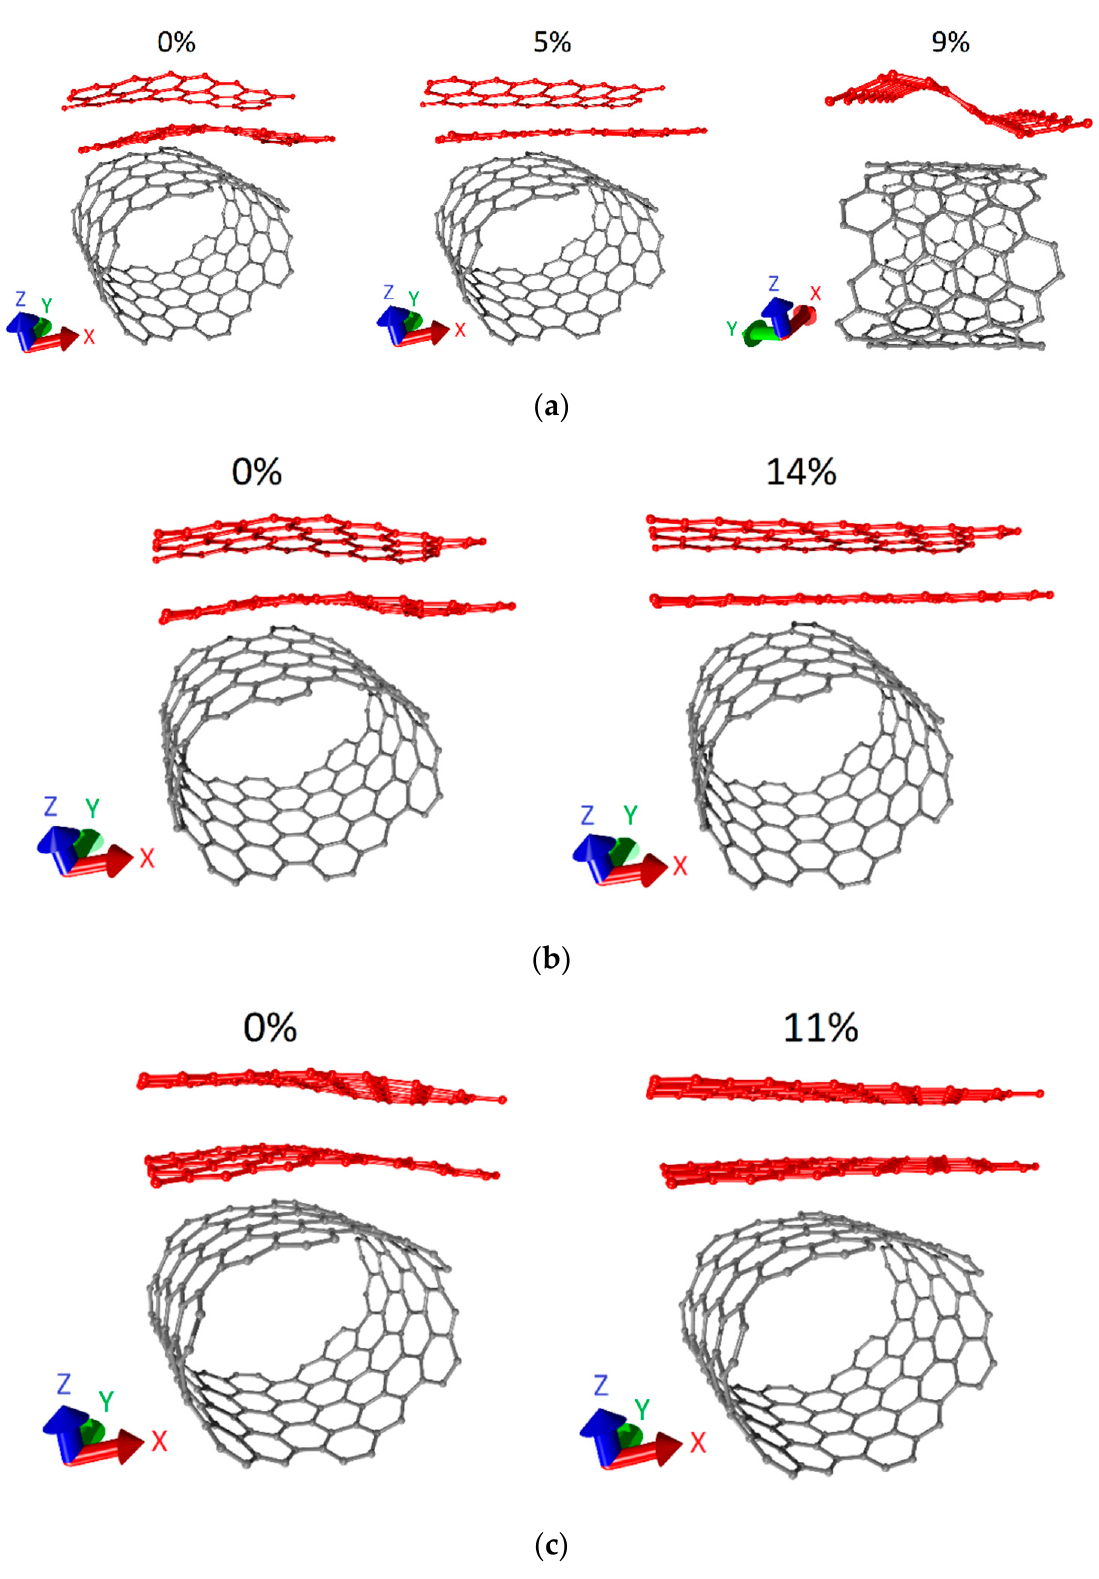
Figure 5. Changes in the atomic structure of supercells of bilayer graphene-SWCNTs (12,6) composite films upon axial tensile: ( a ) model V1; ( b ) model V2; ( c ) model V3.